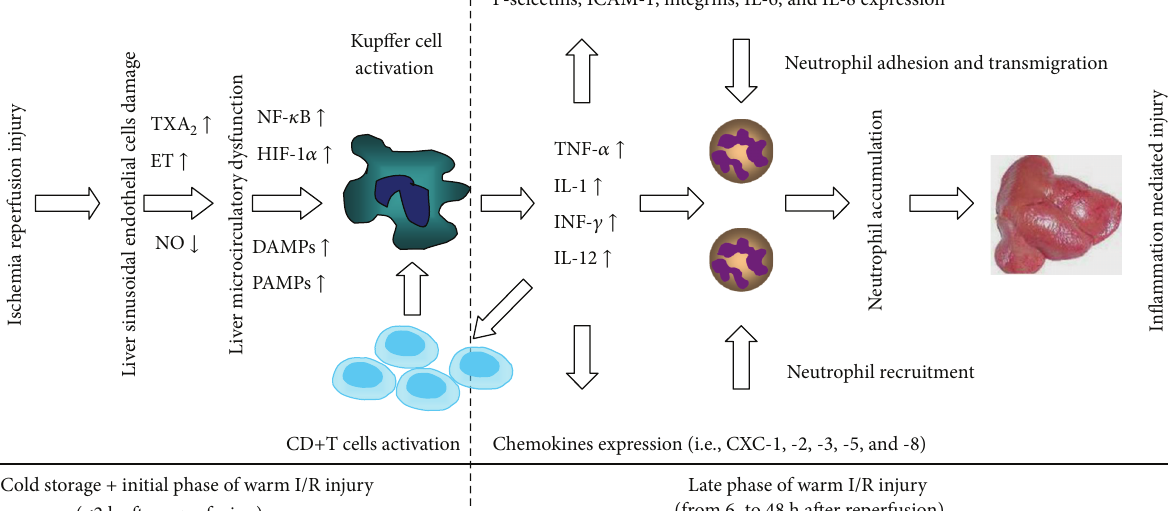
Figure 1: The inflammatory pathways of hepatic ischemia/reperfusion (I/R) injury. Liver sinusoidal endothelial cells (LSEC) damage, which occurs during cold preservation, represents the initial factor leading to liver I/R injury. Kupffer cell (KC) and LSEC edema, together with the imbalance between nitric oxide (NO) ( ↓ ) and thromboxane A2 (TXA2) ( ↑ ) and endothelin (ET) ( ↑ ), contributes to liver microcirculatory dysfunction. KC activation is promoted by damage-associated molecular patterns (DAMPs) ( ↑ ) and pathogen-associated molecular patterns (PAMPs) ( ↑ ) produced by neighbouring hepatic cells. Then activated KCs increase their release of ROS and proinflammatory cytokines including tumour necrosis factor-a (TNF-a), interleukin-1 (IL-1), interferon- (INF), interleukin-12 (IL-12), which induces the expression of P-selectin, intracellular adhesion molecule-1 (ICAM-1), integrins, IL-6, IL-8 in LSEC and the release of chemokines (i.e., CXC-1,-2,-3,-5, and -8).Additionally,IL-1andTNF-arecruitandactivateCD4+T-lymphocytes,whichamplifyKCactivationandpromoteneutrophilrecruitment and adherence into the liver sinusoids and finally execute liver inflammation and